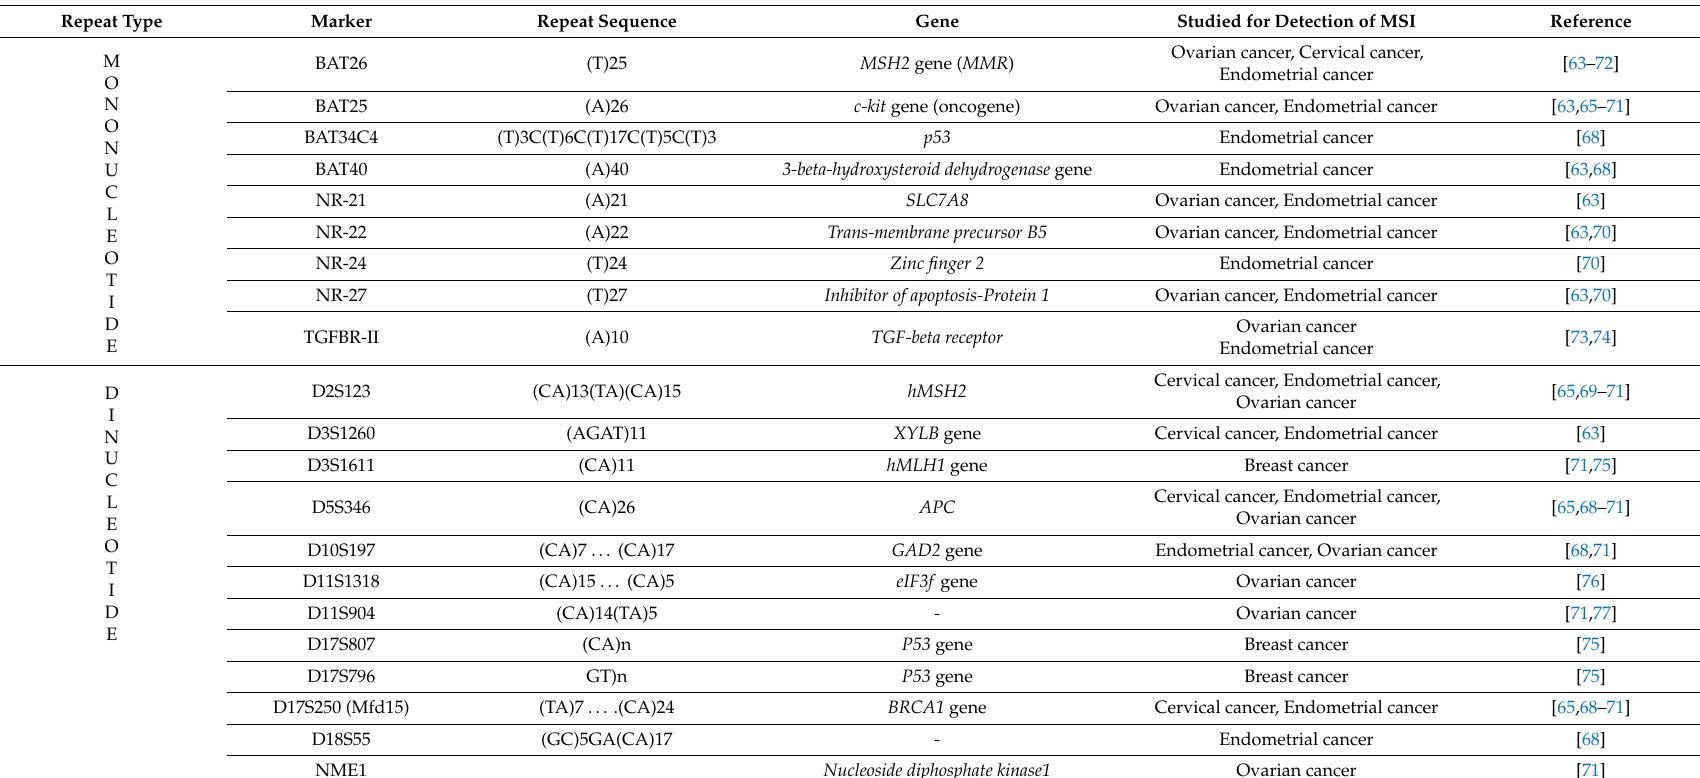
Table 1. Details of the markers used for detection of microsatellite instability (MSI) gynecological